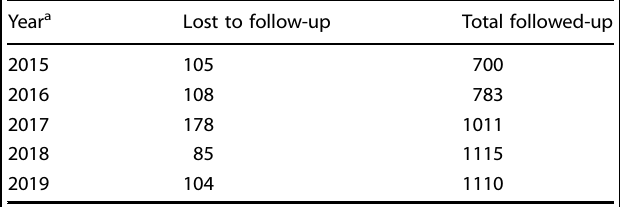
Table 3. Patients lost to follow-up per